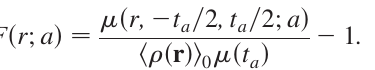
FIG. 3. Excitations are localized and follow Boltzmann statistics of a dilute gas. (a) Distribution of instanton times for excitations with displacement length a ¼ (cid:3) for the W model at several temperatures below its onset temperature, T density a distance r from an excitation, relative to its value at r ¼ (cid:3) for a displacement length a ¼ (cid:3) . The system considered here is the KA model at density (cid:8) ¼ 1 : 2 at equilibrium conditions in the supercooled regime. (c) Same as (b) but for very cold nonequilibrium conditions, sampled using transition-path sampling. The insets of (b) and (c) show the corresponding temperature dependence of r t r (cid:9) ð t a Þ ¼ hj (cid:2) i ð a Þ (cid:1) (cid:2) i ð 0 Þji . (d) Temperature dependence of excitation concentration for excitations on a length scale a ¼ (cid:3) . The data collapse to the single curve when scaled by the plots of (cid:1) ln c a versus 1 =T (cid:1) 1 =T o and J a are given in Table energy parameter J a . Values of T o